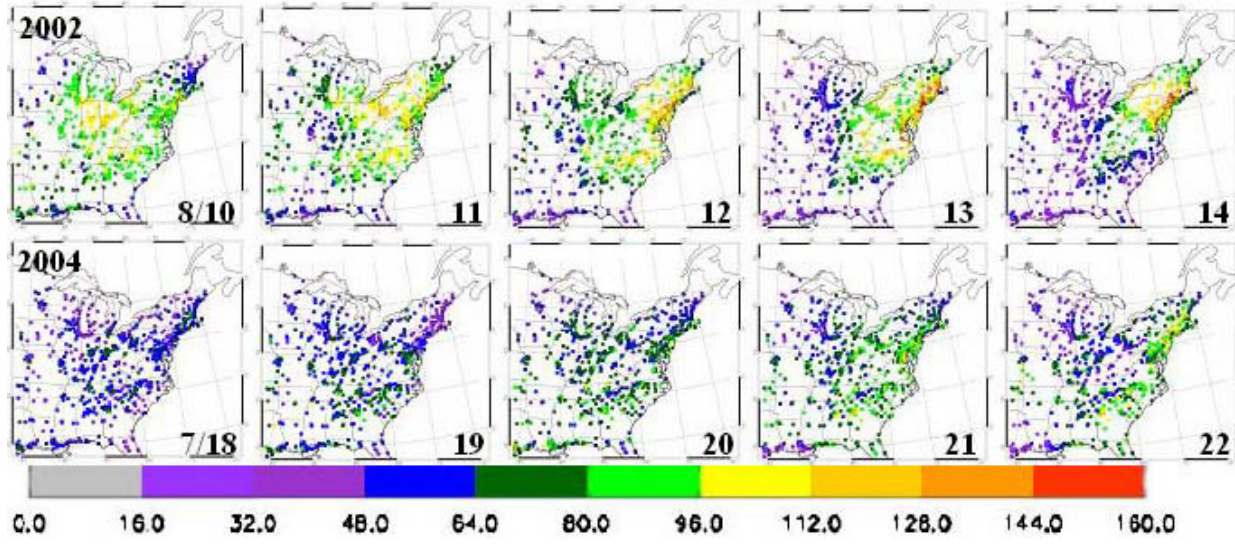
Figure 5. AIRNOW hourly ozone data on 10–14 August 2002 (top), and 18–22 July 2004 (below). Values range is from 0 to 160-ppbv. The color interval is